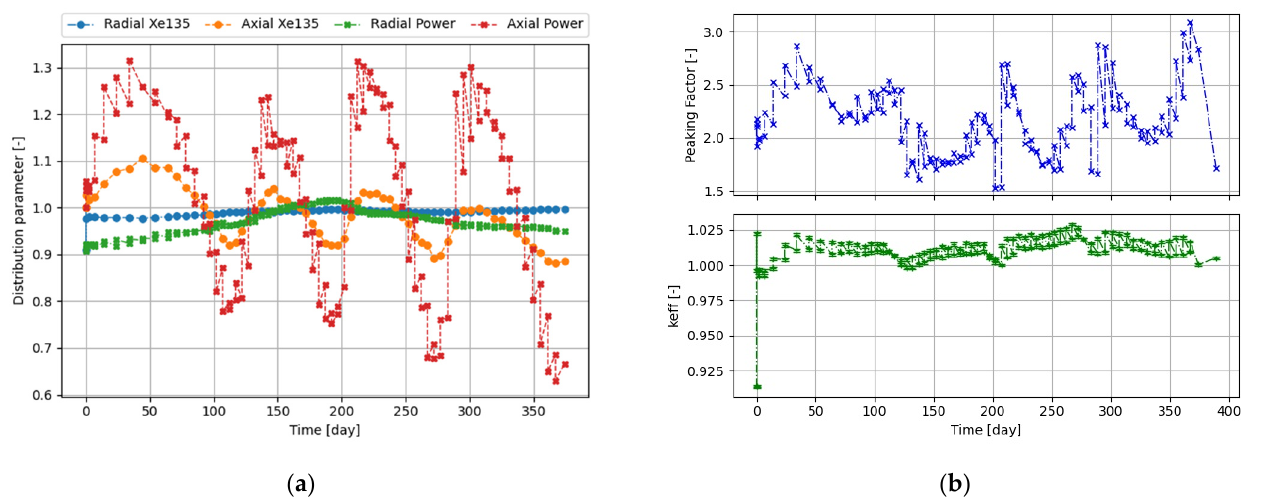
Figure 7. Result of operation strategy St_solid, in refined timestep simulation: ( a ) distribution parameters; ( b ) total peaking